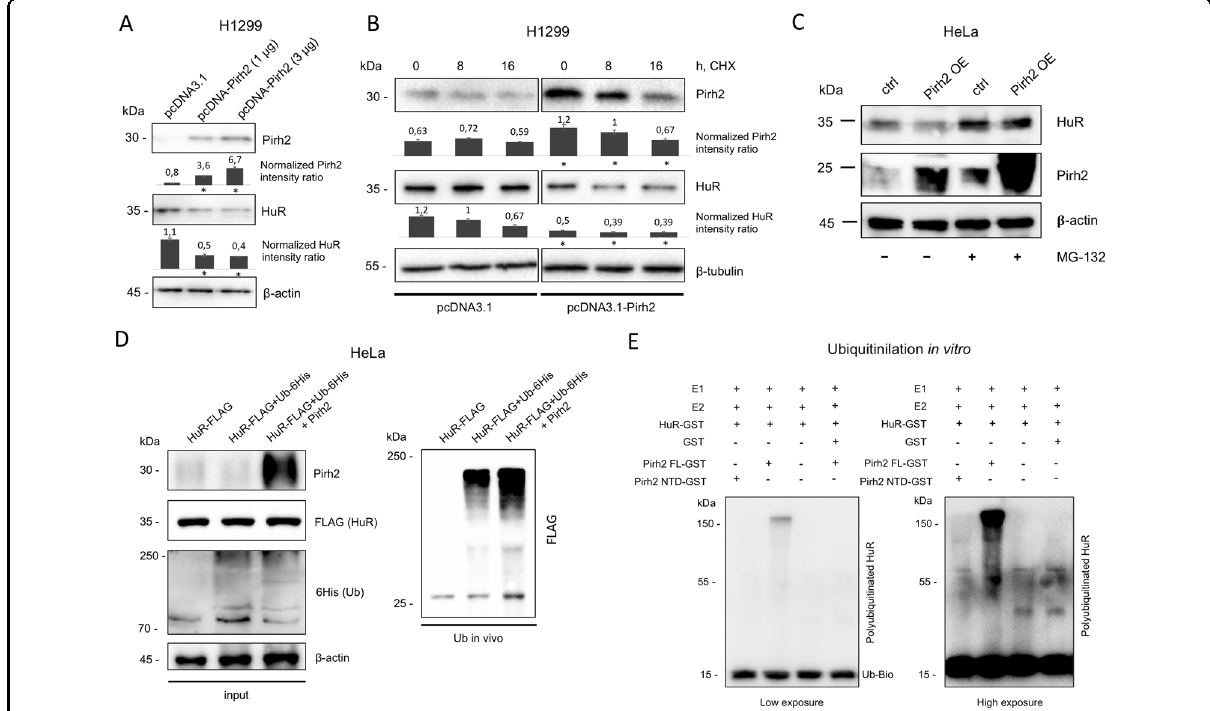
Fig. 3 Pirh2 downregulates HuR level via ubiquitination and targeting for the degradation. A Pirh2 decreases HuR level in H1299 cells. Transfection of H1299 cells with different quantity of pcDNA3-Pirh2 plasmid proportionally decreases HuR level. Empty pcDNA3.1 was used as a control and to keep the total plasmid DNA amount 3 μ g in each sample. The normalized intensity ratios were calculated as ratios between the signals of proteins analyzed and the corresponding actin bands on the basis of three measurements. Error bars indicate ± SD. * p ≤ 0.05 vs. empty vector transfection according to Student ’ s t -test. B Pirh2 shortens half-life time of HuR. Western blot analysis of HuR protein level in H1299 cells transfected with pcDNA-Pirh2 and pcDNA3.1 empty vector, and treated with 50 μ M cycloheximide (CHX) for 8 and 16 h. The normalized intensity ratios were calculated as ratios between the signals of proteins analyzed and the corresponding actin bands on the basis of three measurements. Error bars indicate ±SD. * p ≤ 0.05 vs. empty vector transfection for the corresponding time points according to Student ’ s t -test. C WB analysis of HuR level in HeLa cells transiently transfected with pcDNA3-Pirh2 plasmid (Pirh2 OE) and pcDNA3.1 as a control (ctrl). The cells were treated with 10 μ M MG132 for 16 h. D Pirh2 ubiquitinates HuR in cellulo. Western blot analysis of Ni-agarose-precipitated 6His-ubiquitinated HuR protein from HeLa cells transfected with pIRES-HuR (HuR-3×FLAG); pIRES-HuR and pcDNA-6His-Ubiquitin (Ub-6His); and pIRES-HuR, pcDNA-6His-Ubiquitin, and pcDNA-Pirh2 (Pirh2). pcDNA3.1 vector was used to keep the same amount of total plasmid DNA in each sample (right). Western blot analysis of Pirh2 and HuR- 3×FLAG in inputs (left). E In vitro ubiquitinilation assay. Ubiquitin-activating enzyme (E1), UbcH5b (E2) and GST-tagged HuR (HuR-GST, substrate), and biotin-tagged ubiquitin were added in equal amounts in each portion of the reaction. GST, full-length Pirh2 (Pirh2 FL-GST), and the catalytically inactive N-terminal domain of Pirh2 1 – 132 a.a. (NTD-GST) were tested for their ability to ubiquitinate HuR. No E3 ligase control was also used. The WB analysis of the ubiquitinilation reaction was performed using anti-biotin antibodies. Two variants of exposure are shown for better illustration. The relative amounts of puri fi ed proteins used in the reaction are demonstrated in Supplementary Fig.